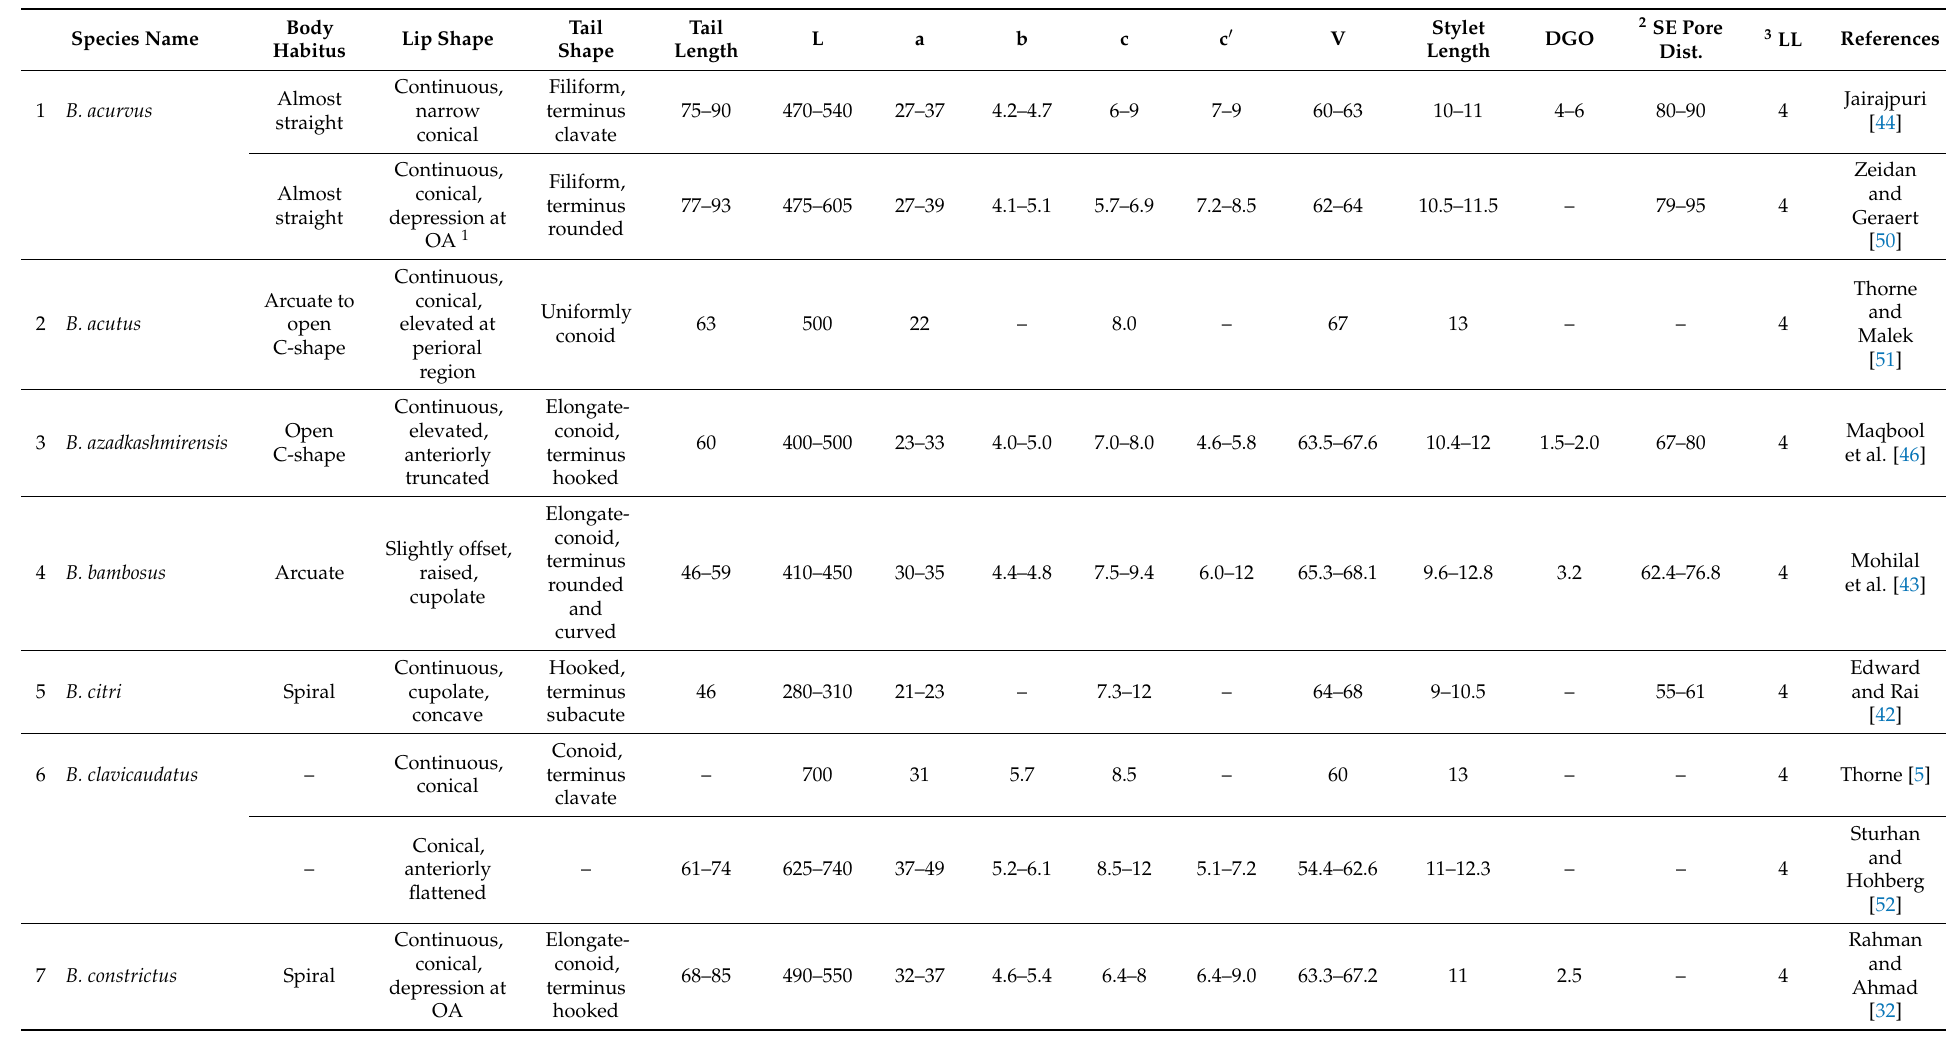
Table 1. Main morphological characters and morphometrics of female Boleodorus species. All measurements are in µ